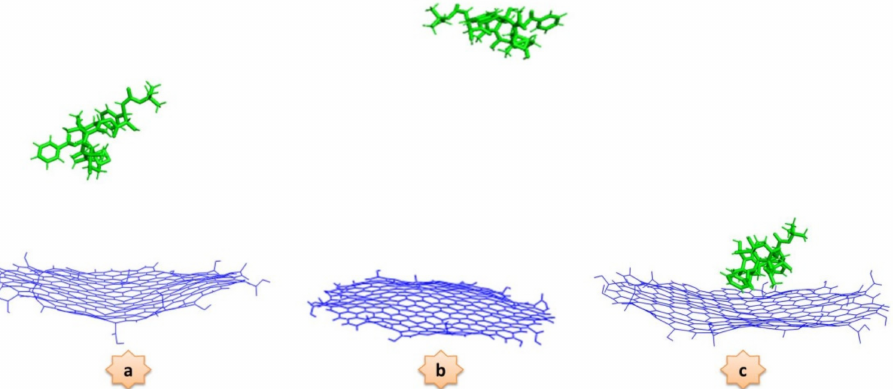
Figure 2. Representative snapshots corresponding to the interaction of docetaxel molecules with graphene quantum dot oxide at three different times: ( a ) 0 ns, ( b ) 25 ns, and ( c ) 50